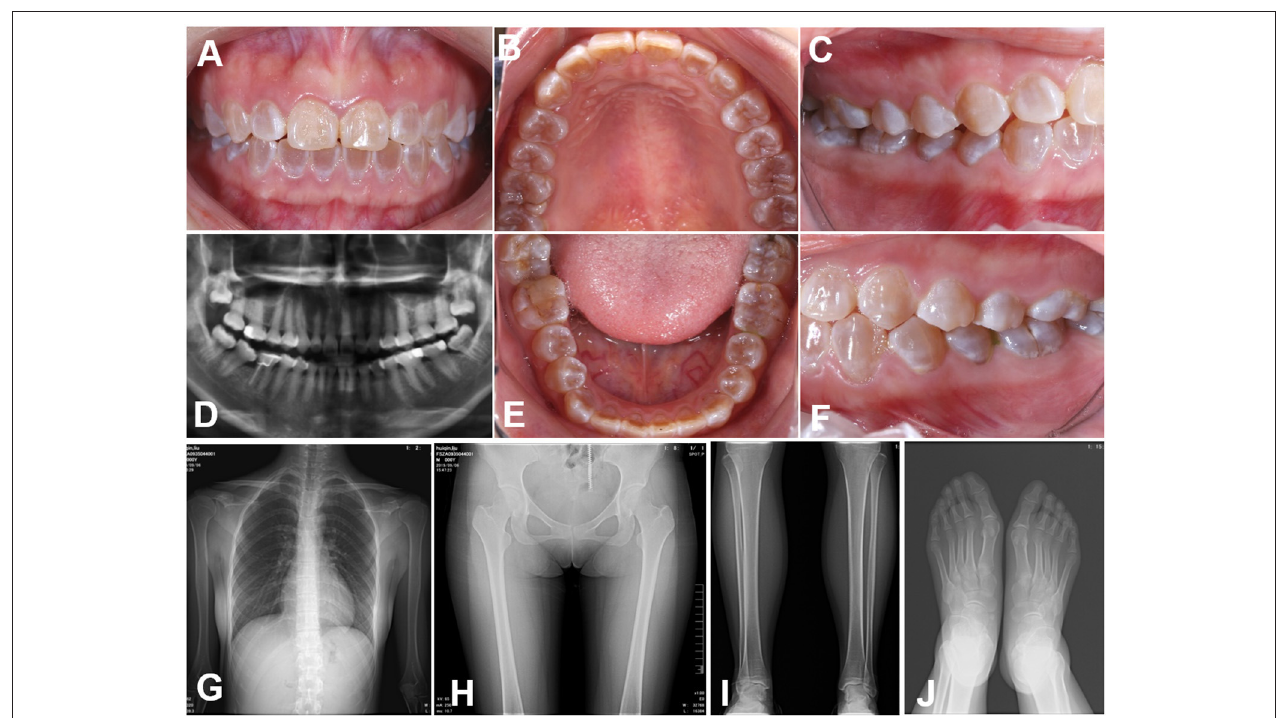
FIGURE 1 | Clinical images (A–E) Intraoral views of the proband. The teeth of the proband were typically amber and translucent and showed significant attrition, especially the molar teeth. (F–J) Panoramic radiographs and radiovisiography images. The pulp chambers and root canals of the affected teeth were smaller than those in normal teeth or completely obliterated. Radiographs of the bones and knees revealed no significant osteopenia, bony destruction, periosteal reactions, or evidence of any acute fractures, dislocations or